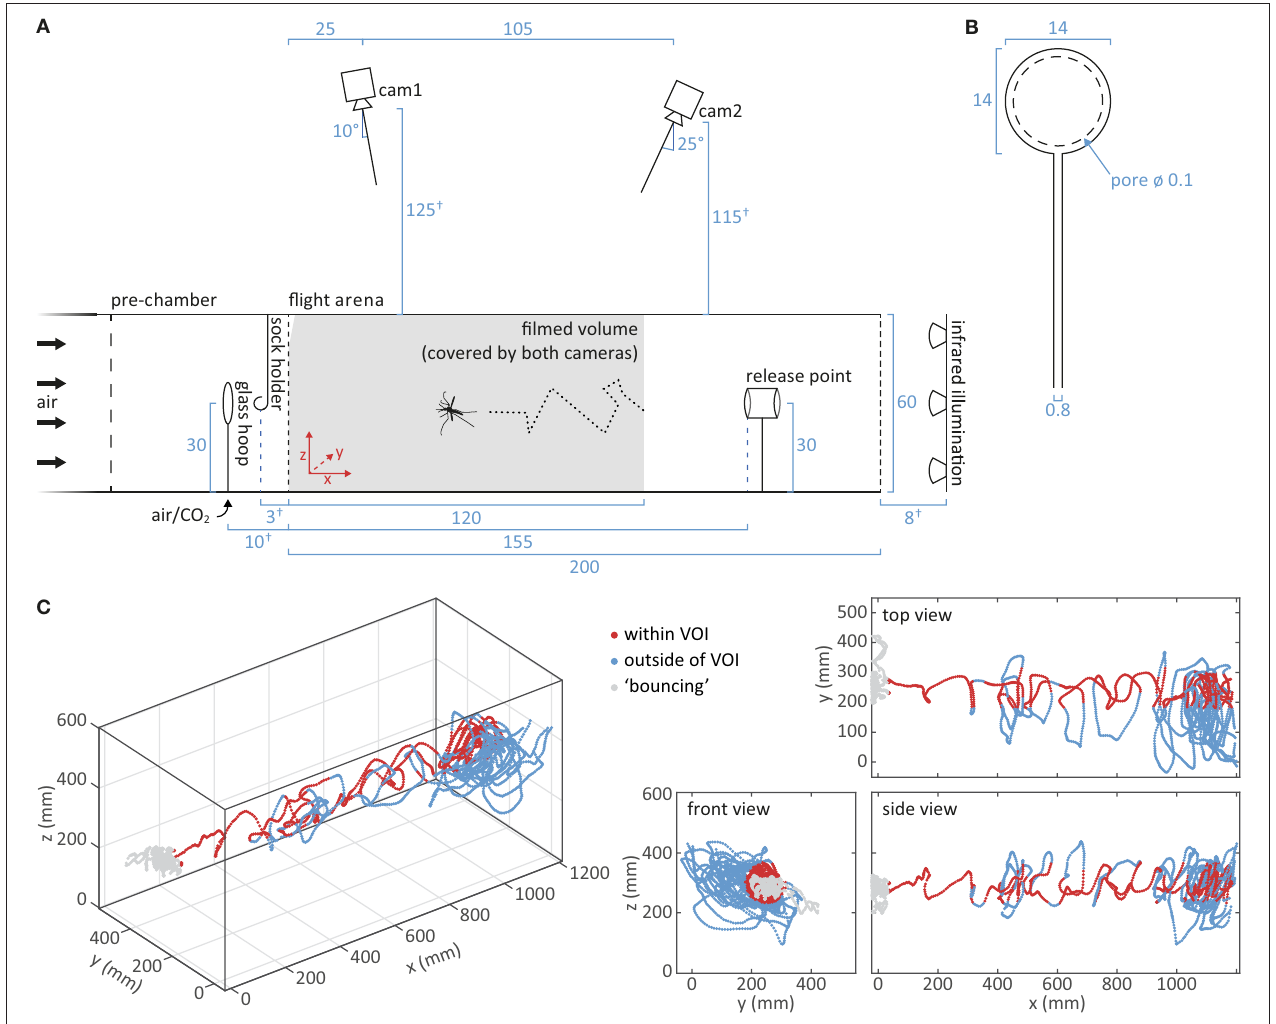
FIGURE 3 | Tracking of mosquito flight. (A) Schematic of the flight arena and the setup for video capture of mosquito flight. A mosquito, released at the release point, flies upwind toward the upwind screen. Cameras mounted above the flight arena record the reflection of the infrared light on the body of the mosquito. The filmed volume, i.e., the area covered by both cameras, is shown in gray. Distance measurements are given in cm. Dimensions drawn to scale, apart from measurements marked by † . (B) Schematic of the glass hoop used for turbulent presentation of CO 2 (Dekker and Cardé, 2011). Measurements are given in cm. (C) A representative flight trajectory of a single mosquito in response to carbon dioxide and human foot odor, viewed from different angles. Positions within the cylindrical volume of interest (VOI) are indicated in dark red, whereas positions outside the VOI are in light blue. “Bouncing” at the upwind screen is denoted in